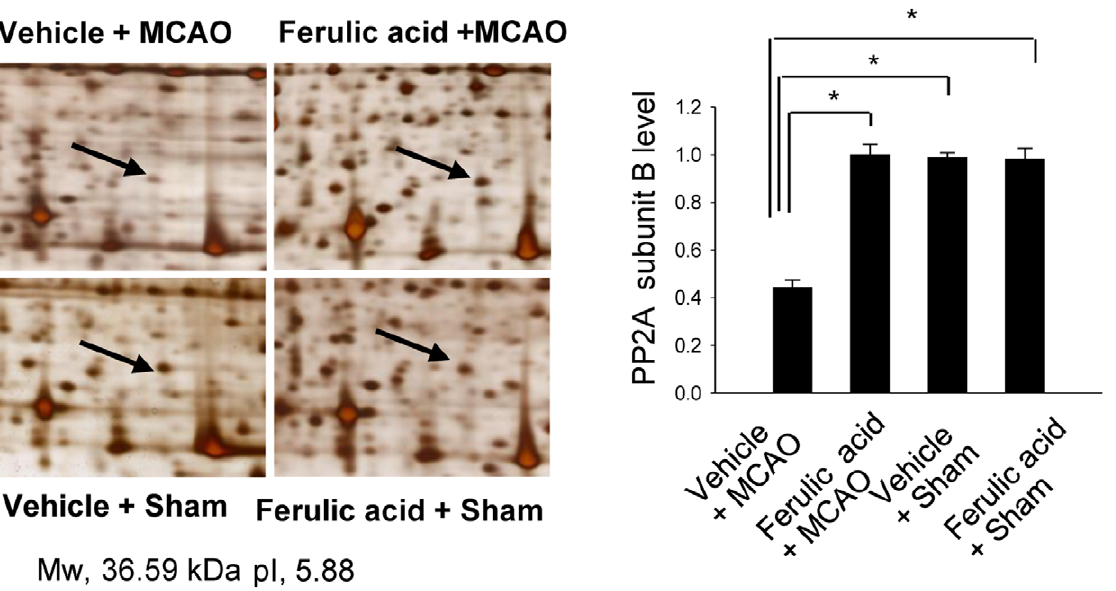
Figure 2. The change of protein phosphatase 2A (PP2A) subunit B protein spots by ferulic acid in focal cerebral ischemia. Protein phosphatase 2A (PP2A) subunit B protein spots identified by MALDI-TOF in the cerebral cortices from vehicle + MCAO, ferulic acid + MCAO, vehicle + sham, ferulic acid + sham animals. Animals were treated with vehicle or ferulic acid prior to MCAO. Arrows indicate the protein spots. Mw and pI indicate molecular weight and isoelectrical point, respectively. The intensity of spots was measured using PDQuest software. The ratio of intensity is described as spots intensity of these animals to spots intensity of sham + vehicle animals. Data are shown as mean 6 S.E.M. * P , 0.05.